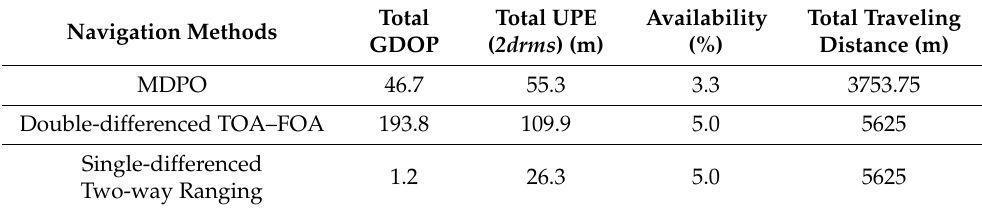
Table 12. The numerical simulation results taking an average of 100 simulation